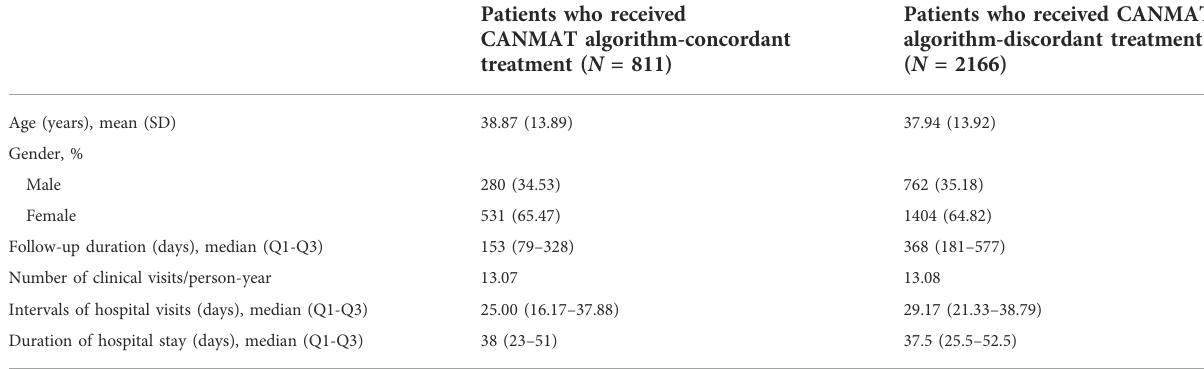
TABLE 5 Demographics and healthcare utilization of patients who received CANMAT algorithm-concordant/-discordant treatment. Patients who received CANMAT